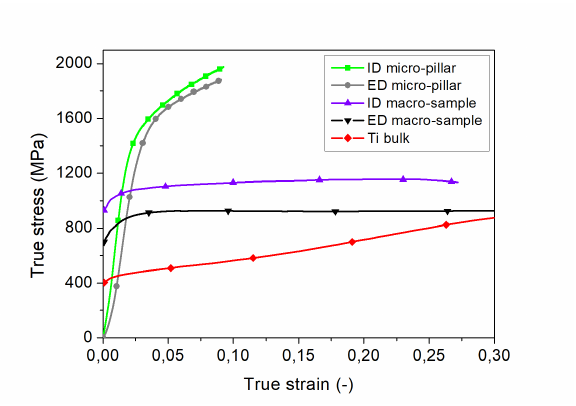
Figure 3. The diagram true compression stress versus true strain for ID and ED micro-pillars, ID and ED macro-samples and titanium bulk